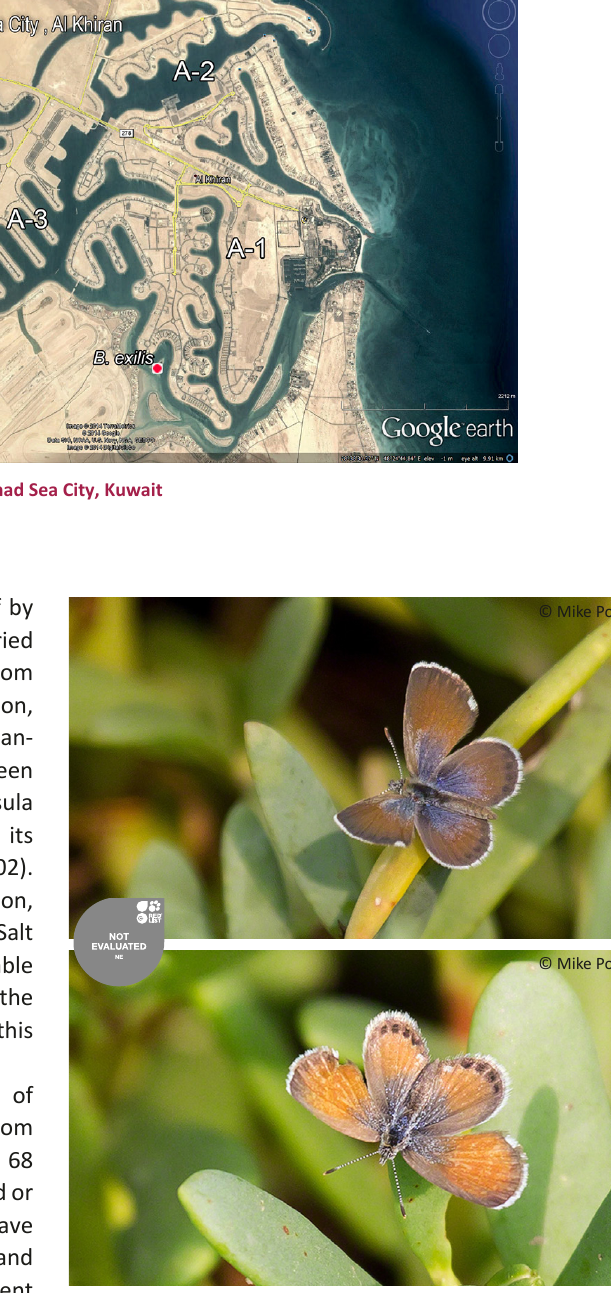
Figure 2. The Western Pygmy Blue Butterfly Brephidium exilis on Sesuvium portulocastrum at Sabah Al Ahmad Sea City, Al Khiran. a - male; b -